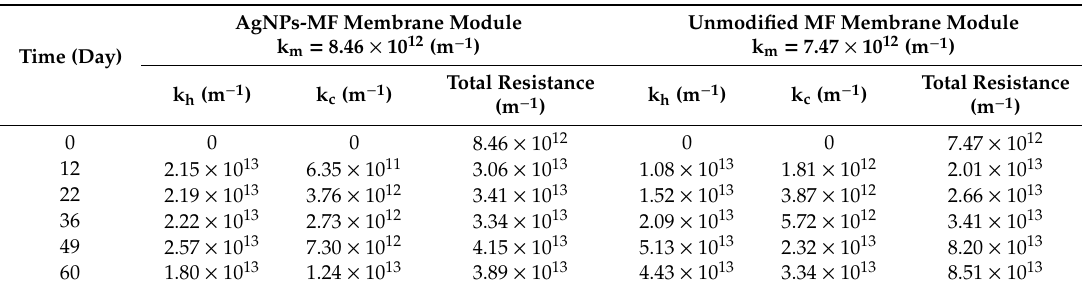
Table 2. Membrane resistance coe ffi cients, hydraulically reversible fouling resistance coe ffi cients, cake layer resistance coe ffi cients and total the resistance of two membrane modules in operation mode calculated by resistance series